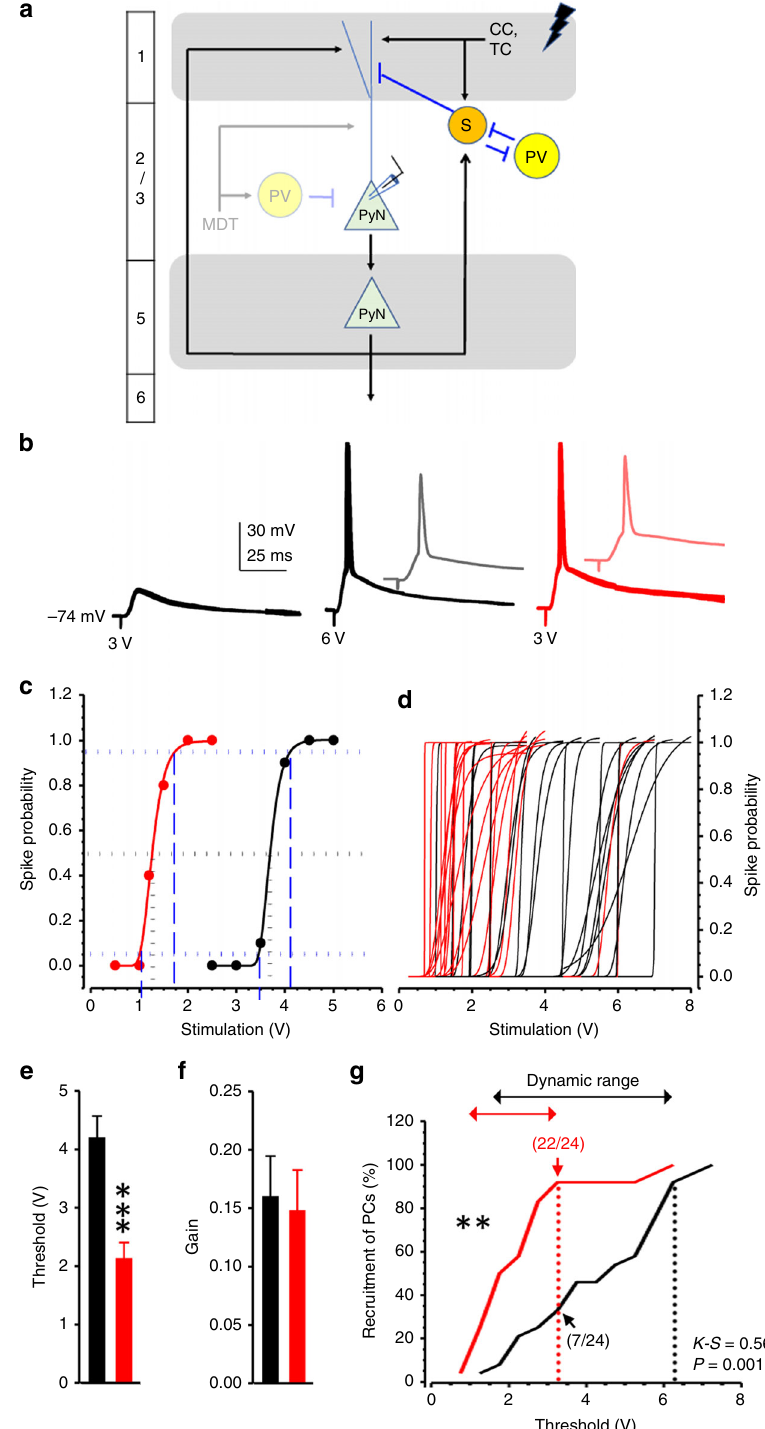
Fig. 6 Reduced threshold and response dynamic range of layer 2/3 pyramidal neurons at the dACC to electrical stimulation at layer 1, where inhibitory inputs are predominantly from SST but not PV interneurons. a Diagram of the inhibitory circuits and placement of stimulation electrodes at layer 1 of the ACC. b Representative traces recorded at − 74 mV showed that an action potential spike could only be elicited in WT neurons (black) by stimulation above 3 V (as shown at 6 V), whereas a 3-V-subthreshold stimulation successfully elicited an action potential spike in PV- Lmo4 KO neurons (red). b – g Current clamp recording showed that L2/3 pyramidal neurons in KO mice are more responsive to L1 simulation. c The spike probability of a representative L2/3 neuron from WT or KO mice. The horizontal dotted lines mark the 5%, 50% and 95% spike probabilities, and the vertical dashed lines mark the stimulation potentials to reach 5% and 95% spike probability. d Spike probability of all WT and KO neurons recorded was sigmoid fi t to obtain ( e ) the stimulation threshold and ( f ) the output gain for 50% of maximum stimulus. n = 24 cells/8 WT, 24 cells/8 KO for ( c – j ). g Stimulation thresholds from all cells are cumulatively plotted. Note that a stimulus that recruited 92 % of KO cells (22/24 cells from 8 mice, red dashed line) only recruited 30% of WT cells (7/24 cells from 8 mice). The dynamic range of WT neurons (black dashed line) was twice that of KO neurons. ** p < 0.01, *** p <